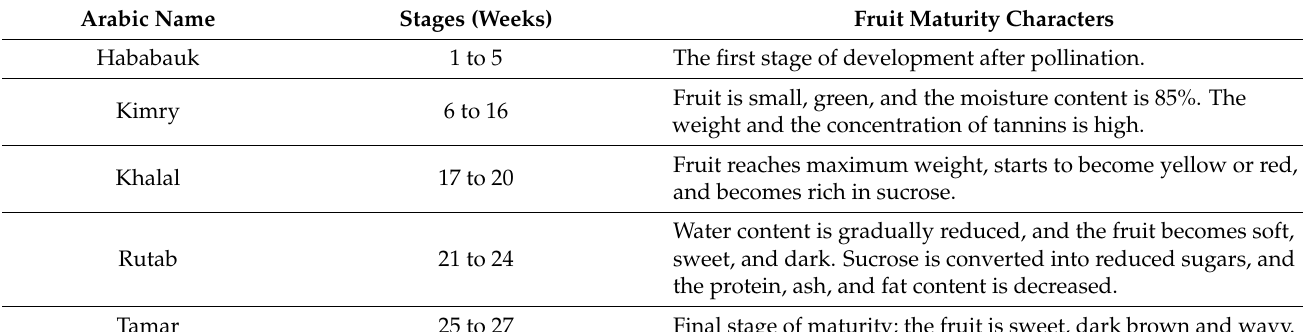
Table 1. Growth stages of Phoenix dactylifera (Medjool) Al-hajjaj and Ayad, 2018 [7].